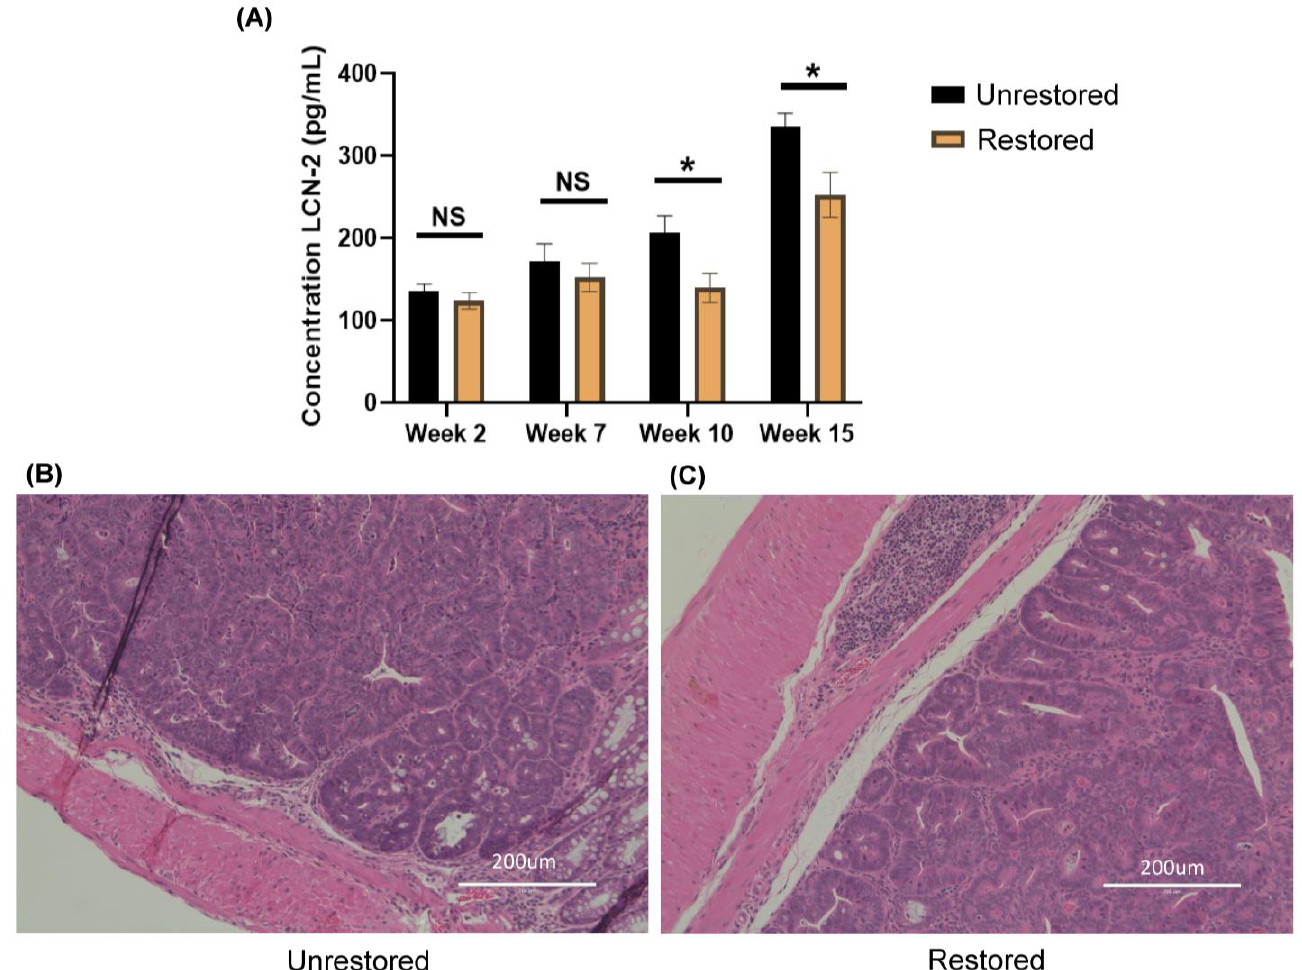
Figure 2. Fecal restoration alters colonic inflammation in Balb/c mice. ( A ) Fecal concentrations of Lcn-2 in unrestored (black) restored (orange) groups at weeks 2, 7, 10, and 15 (left to right) (* p < 0.05) ( n = 3) (+/ − SD). ( B ) Hematoxylin and eosin staining of the colon tissues of unrestored ( C ) Restored Balb/c mice.